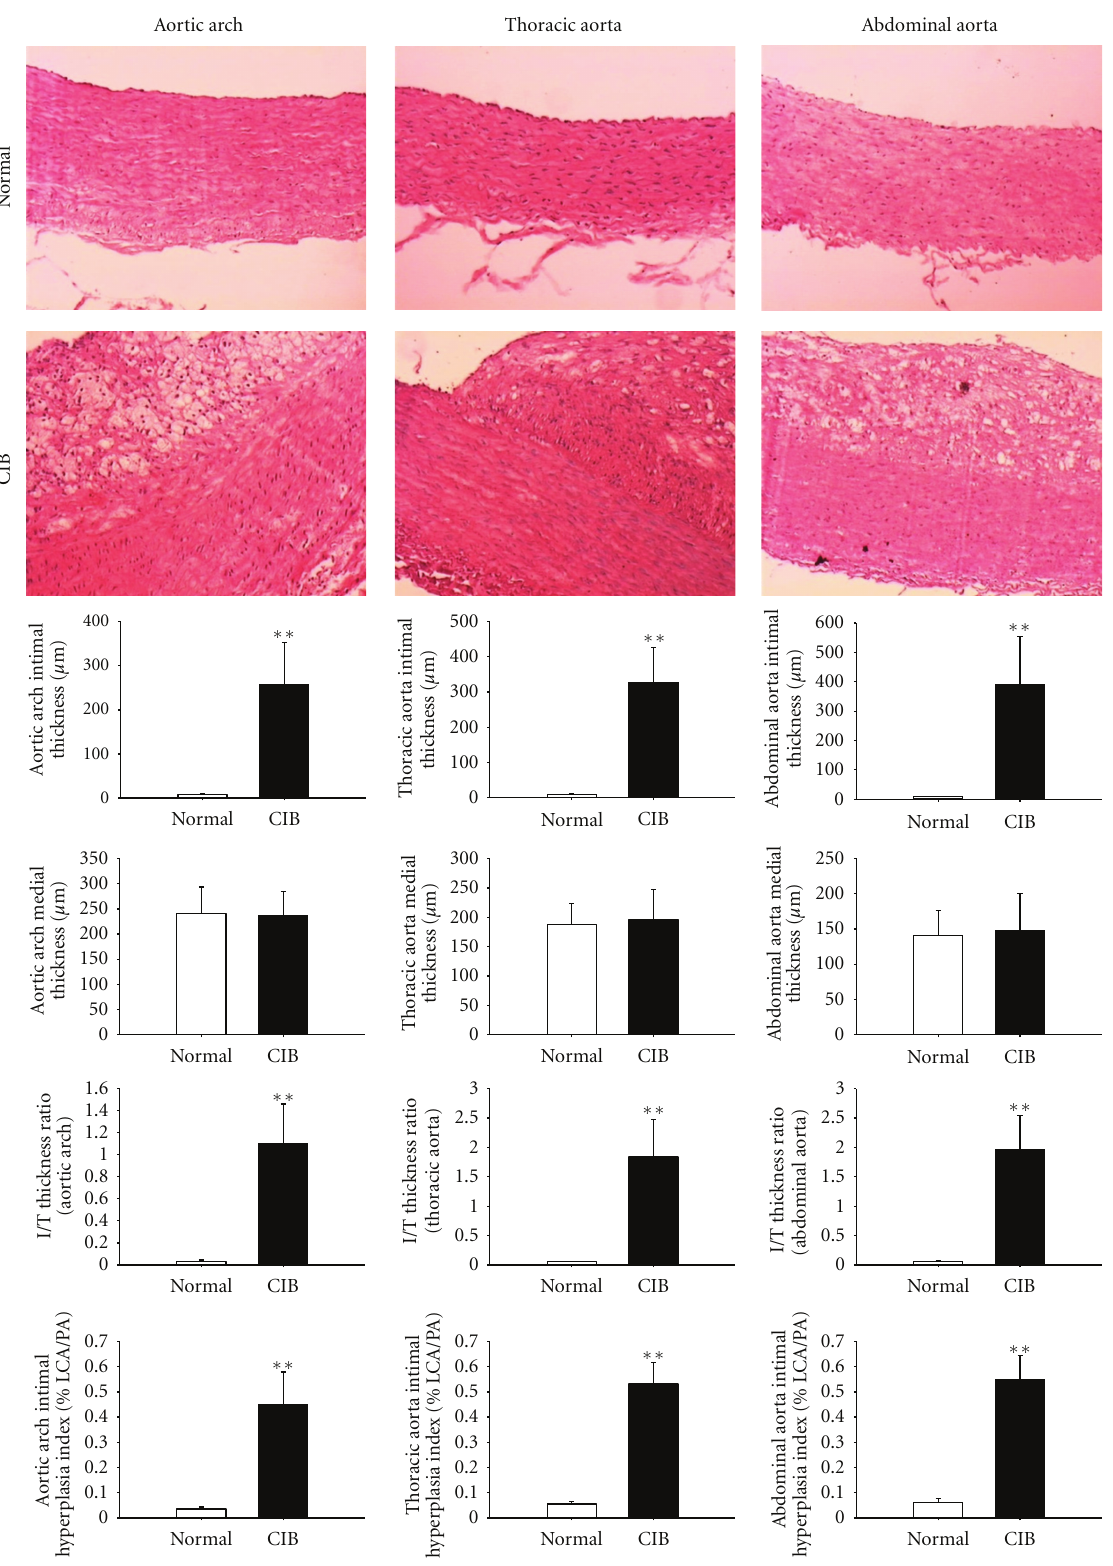
Figure 5: Representative hematoxylin-eosin staining for intima/medial thickness of aortic arch, thoracic aorta, and abdominal aorta (magnification × 40). The pathology of the abdominal aortic was most serious, followed by the thoracic aorta and aortic arch. Data are expressed as mean ± SD, ∗ P < 0 . 01, ∗∗ P < 0 . 01 compared with normal